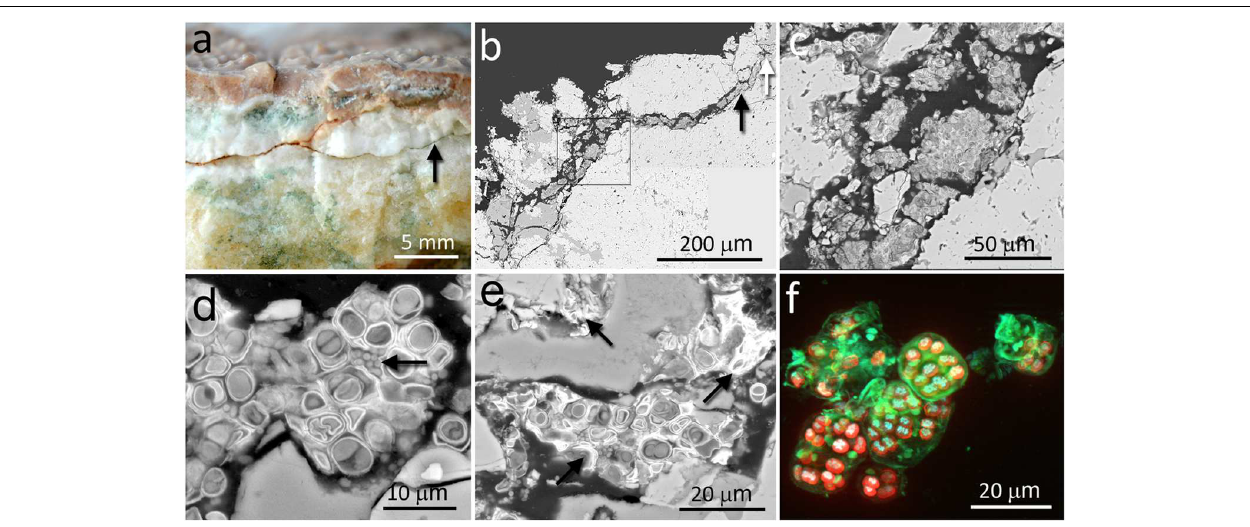
FIGURE 1 | Chasmoendolithic microbial communities within the fissures and cracks of calcite rocks. (a) Freshly fractured calcite shows a fissured wall with green spots – chasmoendoliths; arrow points to a fissure parallel to the rock surface that is also colonized; at the surface, hardened layer with microrills. (b) SEM-BSE low magnification image of transversal section showing fissures connected to the rock surface and filled by chasmoendolithic colonization; the square, black and white arrows point to detailed (c–e) images, respectively. (c) SEM-BSE image shows chasmoendolith’s aggregates colonizing fissure walls. (d) SEM-BSE image shows well developed cyanobacteria surrounded by EPS and heterotrophic bacteria (arrow). (e) SEM-BSE image shows collapsed cyanobacteria cells and remains of microbial colonization (arrows). (f) SIM 3D image of cyanobacteria aggregates; red signal – cyanobacteria photosynthetic pigments autofluorescence, blue signal – cyanobacteria nucleoids and green signal sheaths of EPS surrounding cyanobacteria aggregates and singular cells.